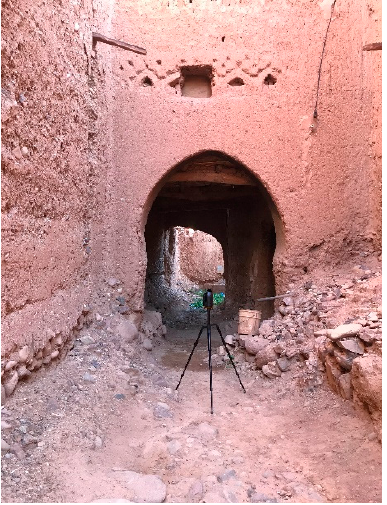
Figure 8. Laser scanner BLK360 during the measurement inside the mellah.